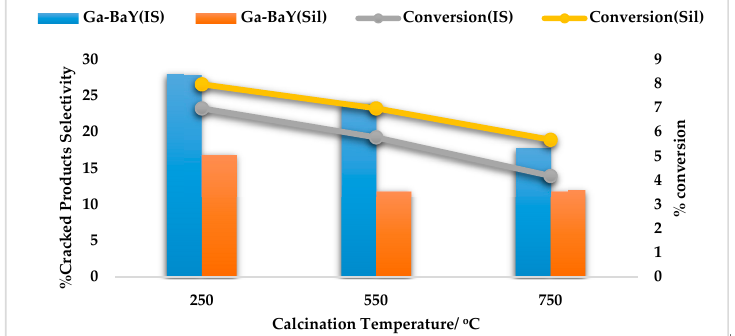
Figure 7. Conversion and cracked products selectivity of Ga-BaY(IS) and Ga-BaY(Sil) calcined at different temperatures. Table 3. Cracked products distribution over Ga-BaY(IS) and Ga-BaY(Sil) calcined at different temperatures. Catalysts